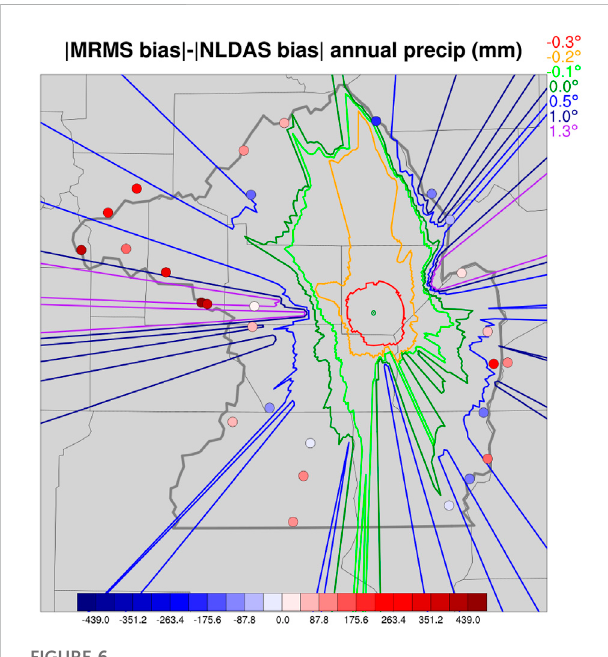
FIGURE 7 Weighting array developed for interpolating between the MRMS precipitation (interior thick gray line for .0 ° radar angle) to the NLDAS precipitation (exterior thick black line for 1.0 ° radar angle.) The upper Rio Grande basin is outlined in green, while the Alamosa radar location is indicated by a small green circle.